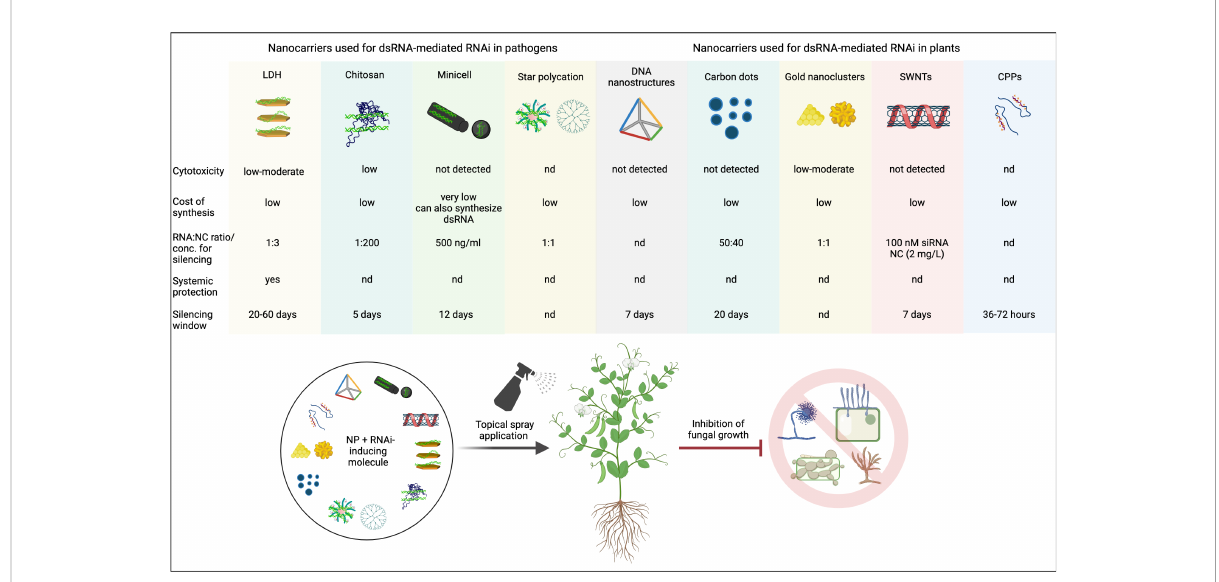
FIGURE 3 A summary of proven and potential nanocarriers and their key features that can be used to enhance the ef fi ciency of RNAi-mediated control of phytopathogenic fungi in crops. NC, nanocarrier; NP, nanoparticle; LDH, layered double hydroxides; SWNTs, single walled carbon nanotubes; CPP, cell penetrating peptides. Created with